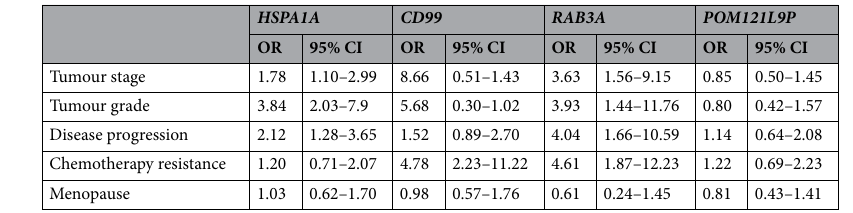
Table 3. Association of candidates with clinicopathological characteristics. OR odds ratio, CI confidence